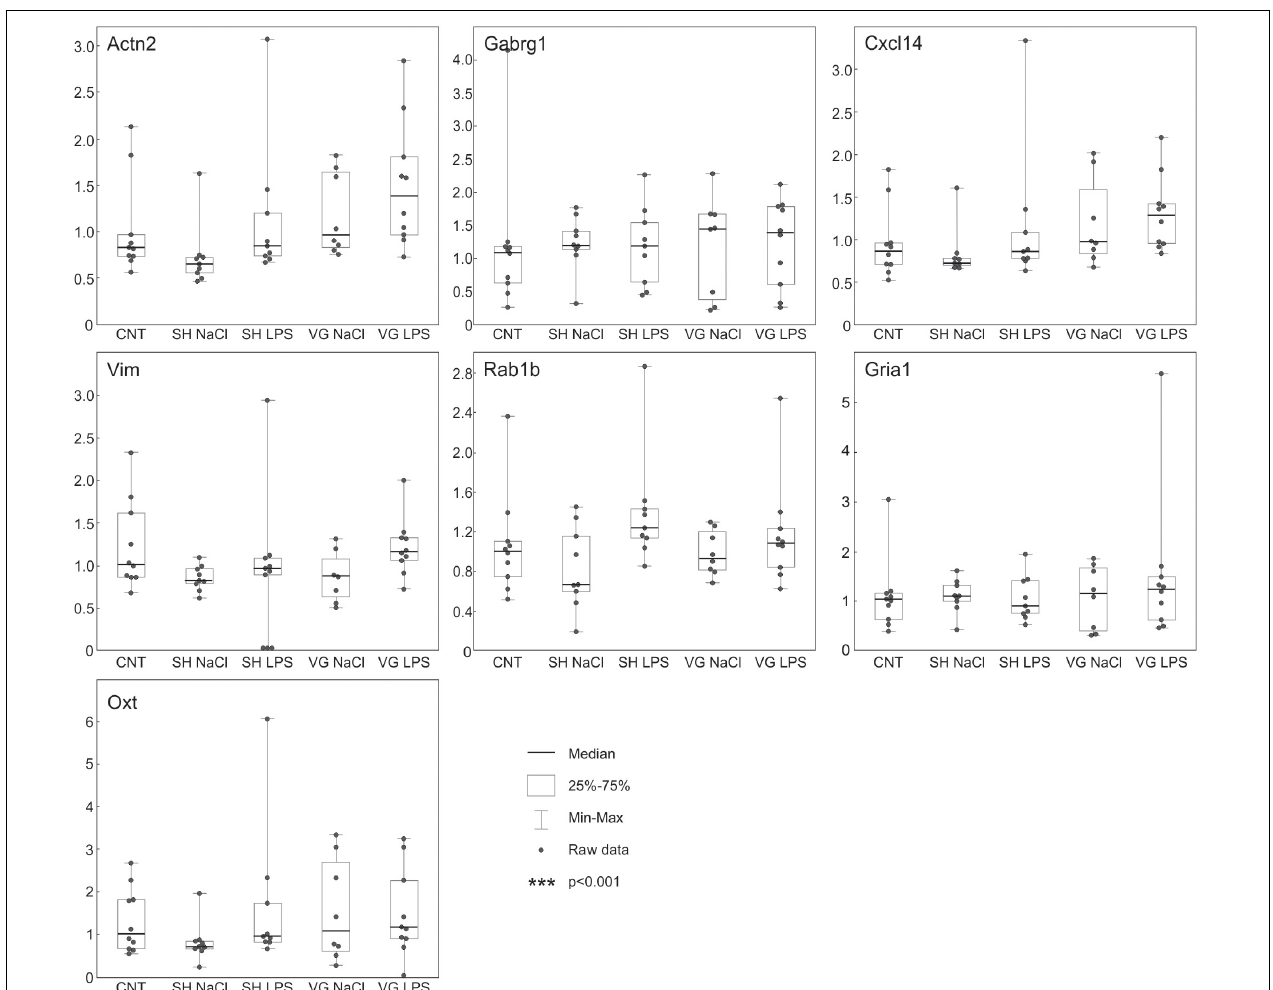
FIGURE 3 | QPCR analysis confirms that experimental procedures did not affect the hypothalamic gene expression pattern. The whiskers extend from the hinge to the smallest/largest value no further than 1.5 × IQR from the hinge (where IQR is the inter-quartile range, or distance between the first and third quartiles). Data beyond the end of the whiskers are called “outlying” points and are plotted